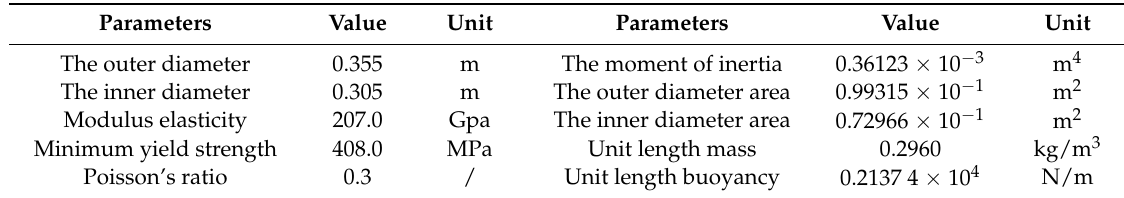
Table 2. Parameters of the SCR bearing layer [10].